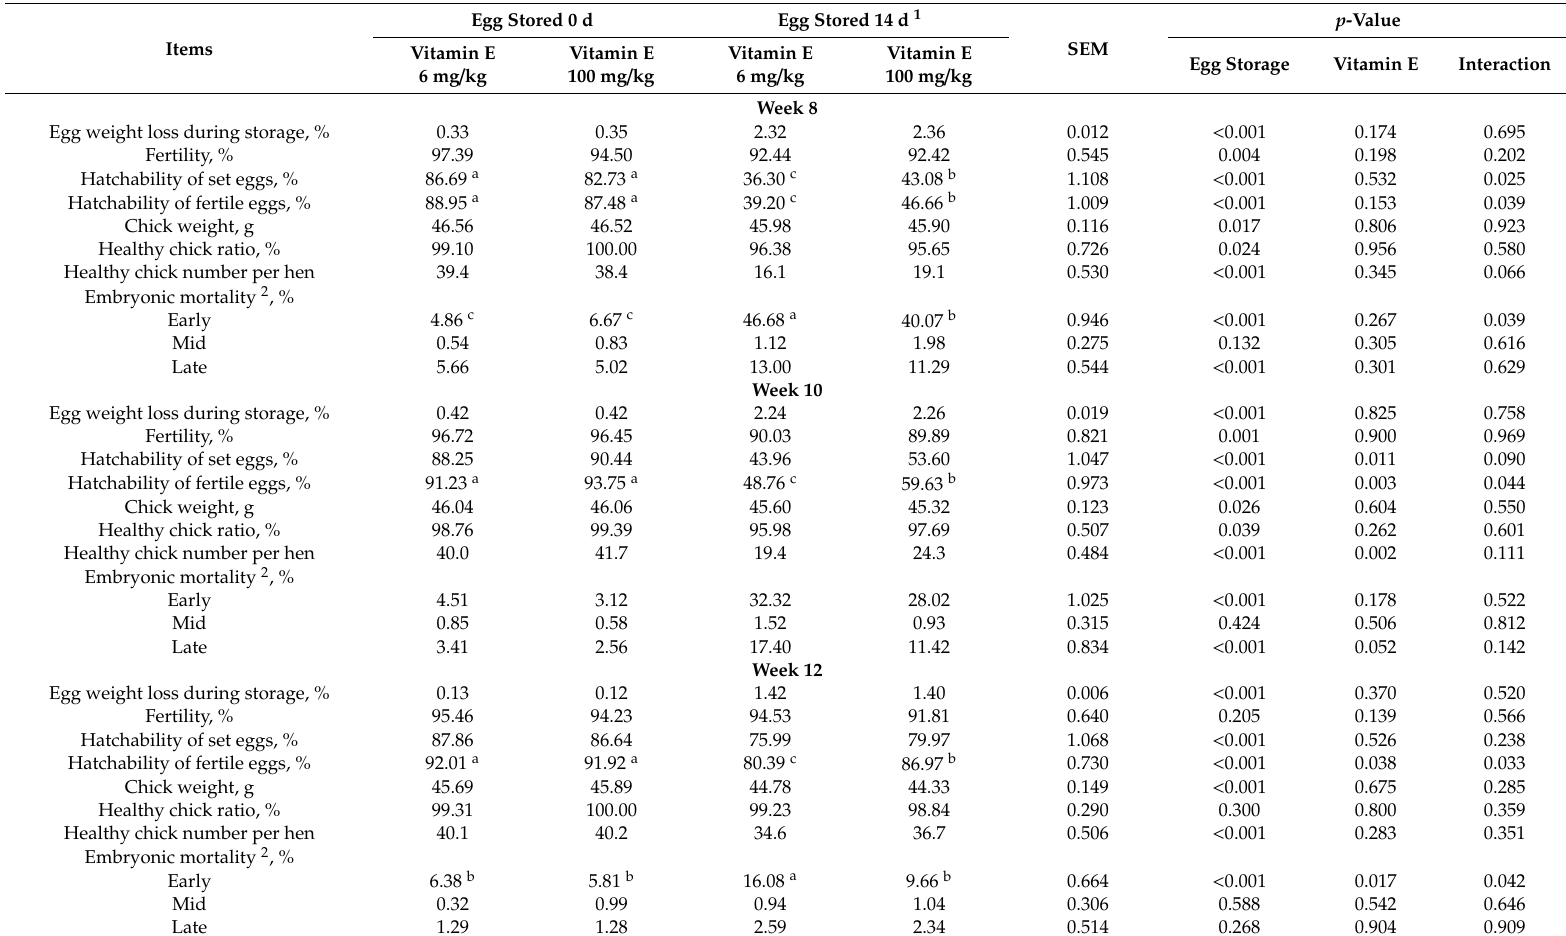
Table 3. Thee ff ects of broiler breeder dietary vitamin E and egg storage time on the hatchability and embryonic